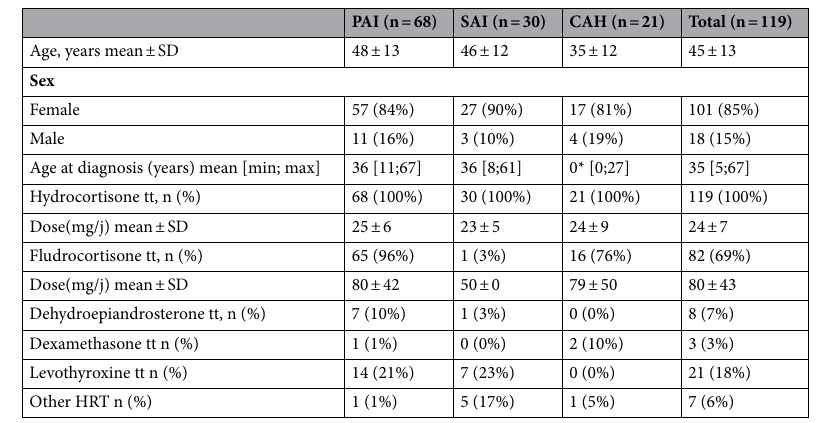
Table 1. Patient characteristics. PAI primary adrenal insufficiency, SAI secondary adrenal insufficiency, CAH congenital adrenal hyperplasia, tt treatment, HRT hormone replacement therapy. *At birth in 16 patients.